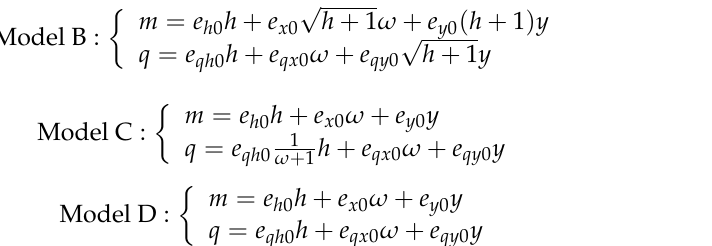
1 , S 2 , S 3 and S 4 . ( a ) S 1 ; ( b ) S 2 ; ( c ) S 3 ; ( d ) S 4